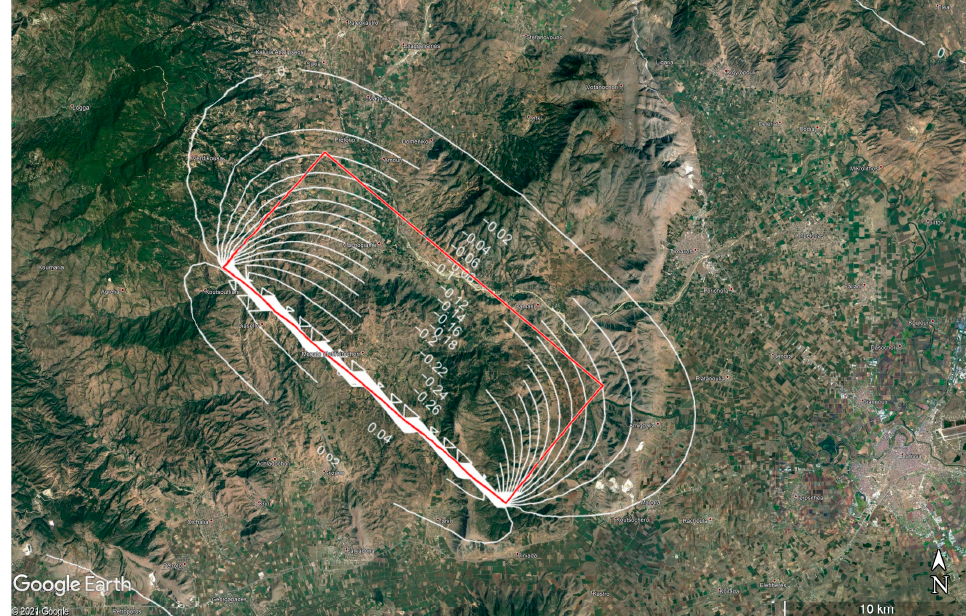
Figure 15. The seismic fault model (seismic source) of the mainshock, based on the GFZ’s moment tensor solution and the hypocentral spatial distribution of Figure 9, and the modelled vertical ground deformation after the implementation of the Okada formulae [80]. Surface fault trace projection between the villages Zarko and Megalo Eleftherochorion. After Chatzipetros et al.